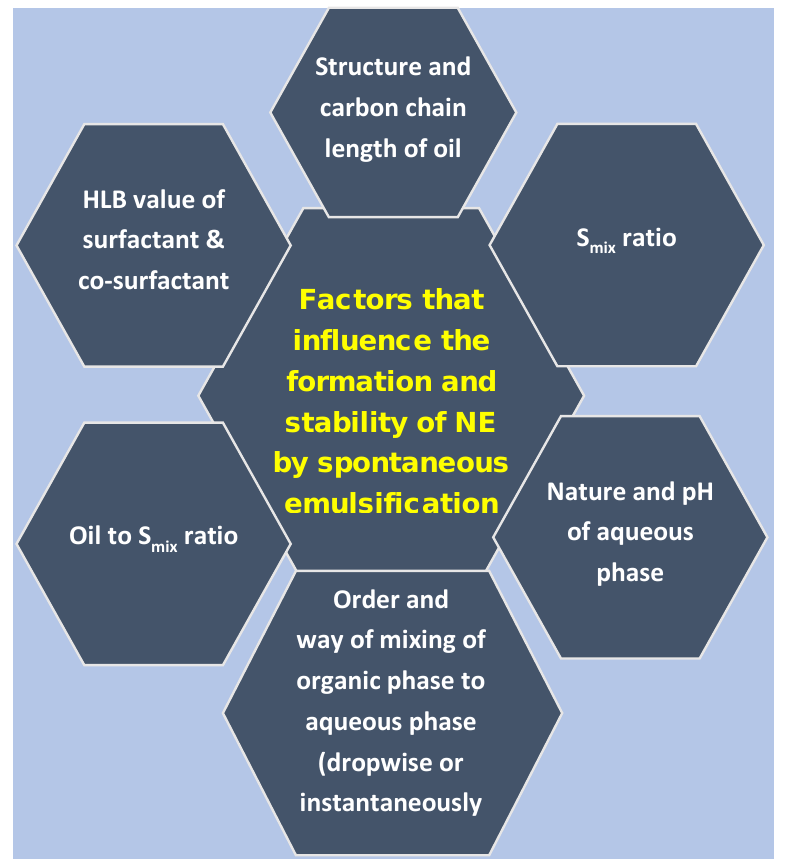
Figure 1. Schematic that shows the possible factors that affect the formation and the stability of NE via spontaneous emulsification.